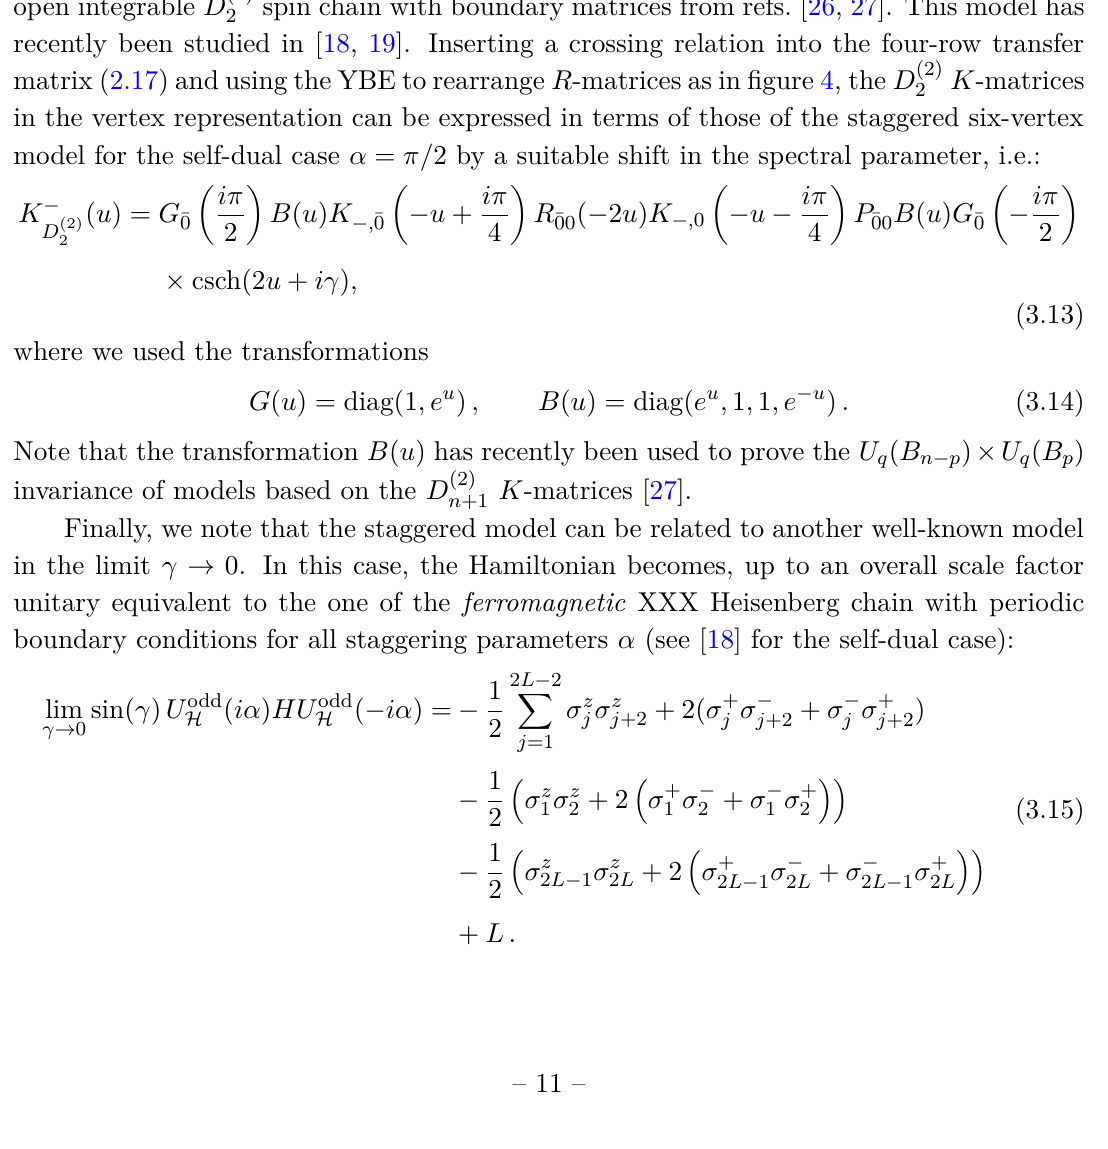
and some gauge 2